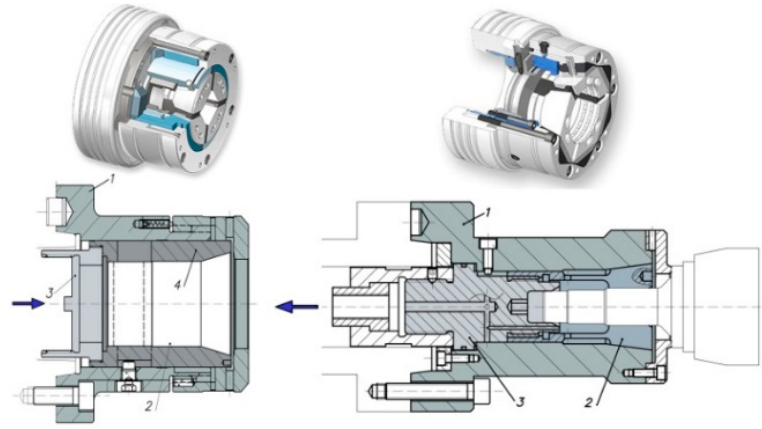
Figure 1. Collet chuck acting by pushing and by pulling.